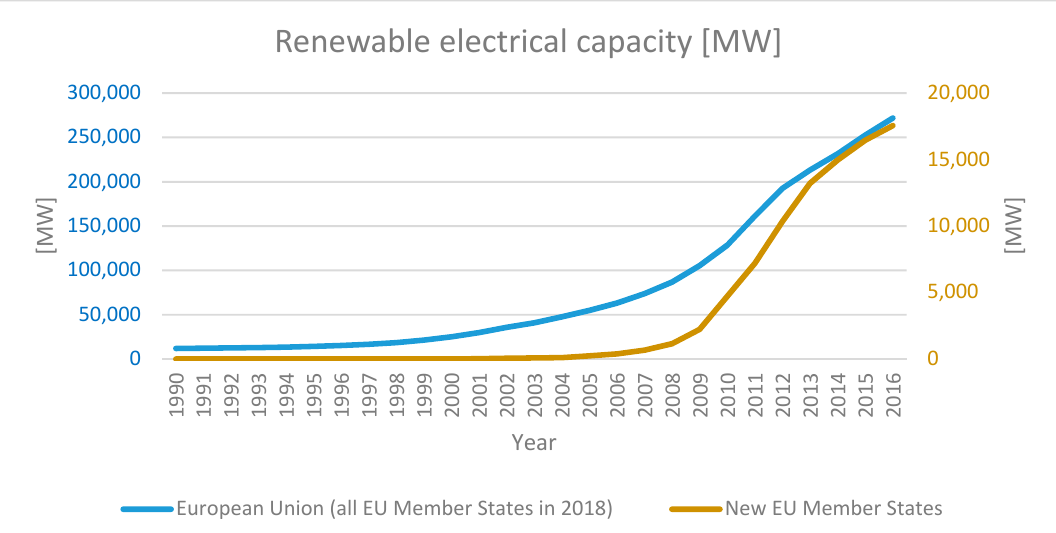
Figure 1. Joint electrical capacity in the European Union (EU). Source: Own visualizations based on [70].